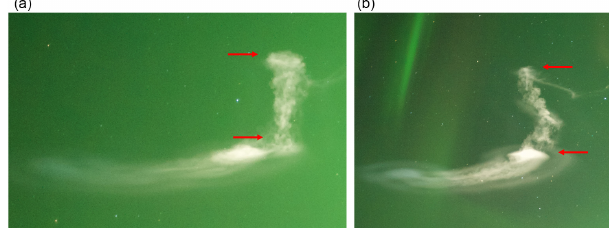
Figure 18. Photographs of the MIST-1 (a) and MIST-2 (b) down- leg trail from Toolik Lake (a) taken at 09:23:24 and 09:56:24UT, respectively. The arrows indicate the bottom and top of the quasi- adiabatic layer near 95 and 100km,